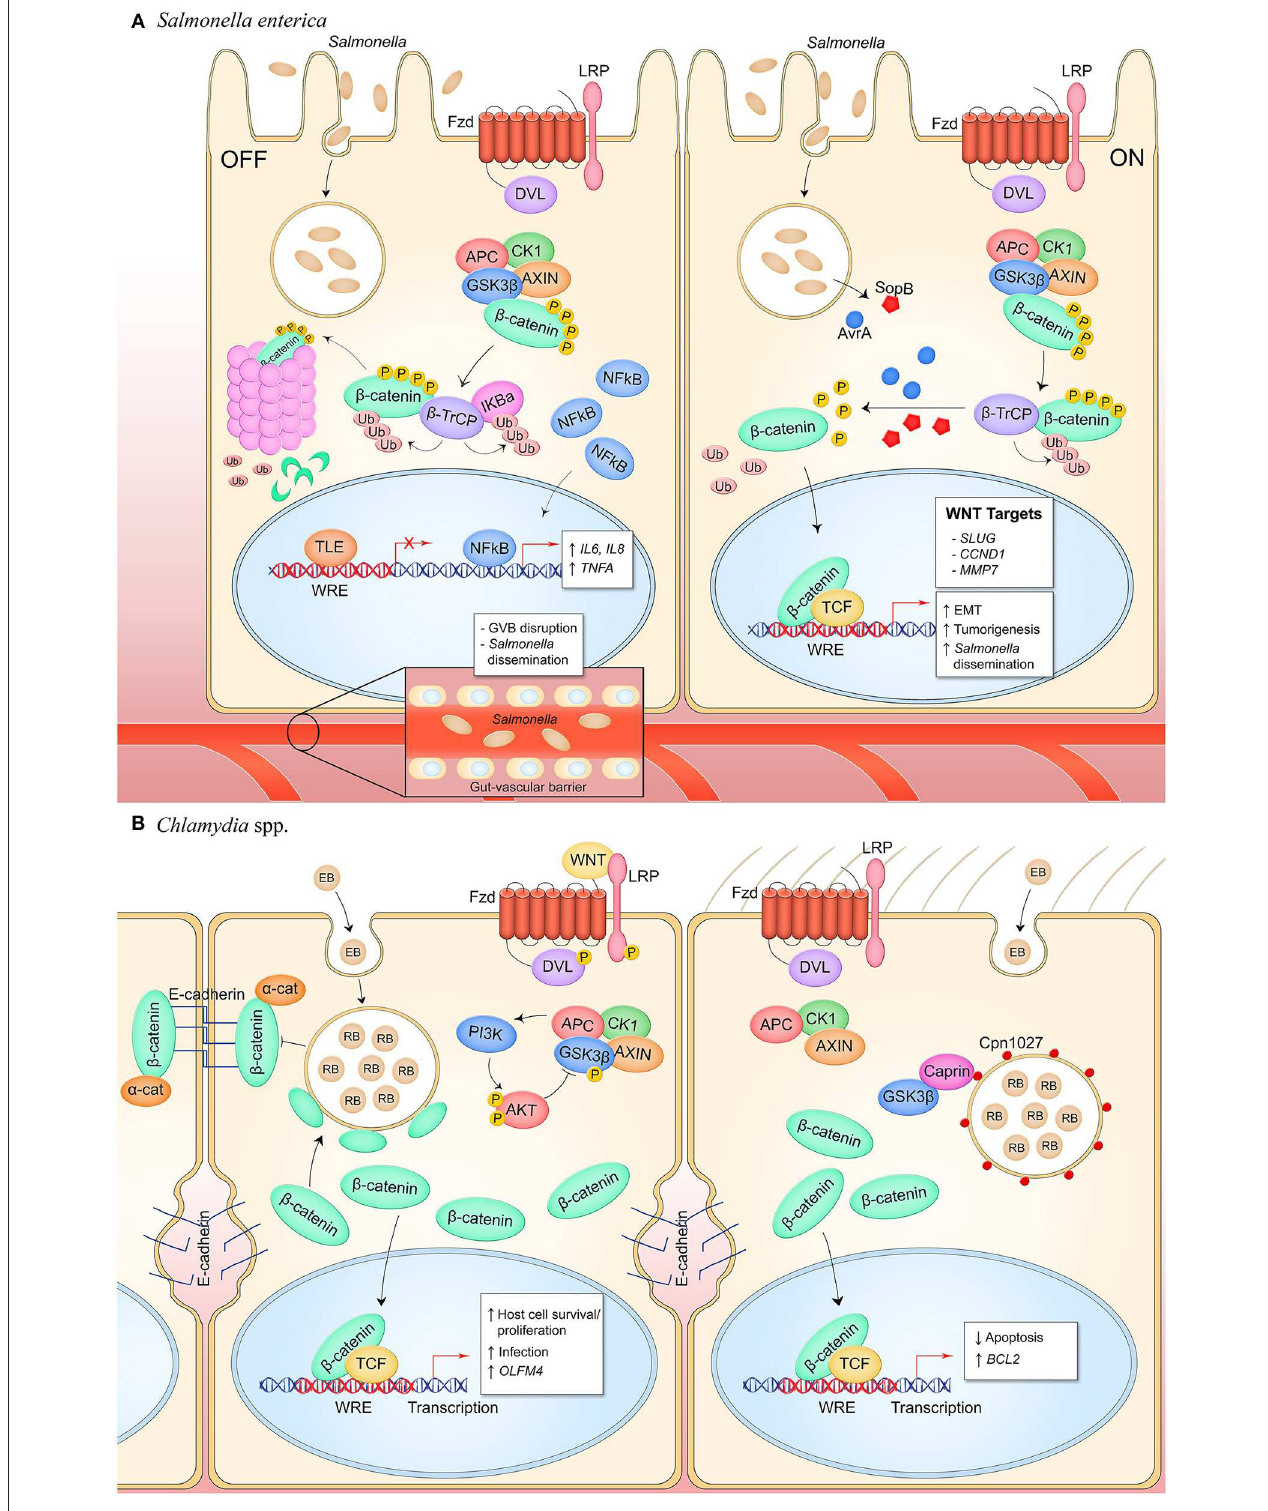
FIGURE 3 | Canonical Wnt signaling manipulation during bacterial infection of epithelial cells. (A) S. enterica infection of intestinal epithelial cells inhibits Wnt signaling through an unknown mechanism (left). Activity of the E3 ubiquitin ligase β -TrCP, which targets both β -catenin and I κ B α for proteasomal degradation, stabilizes NF- κ